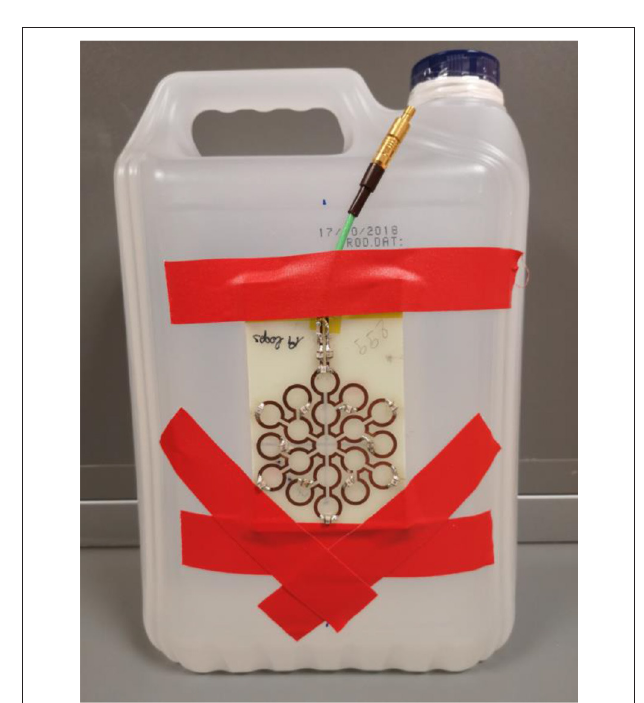
FIGURE 2 | Photograph of the phantom with the 7T MLC attached to